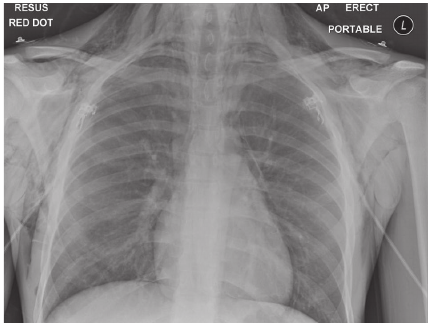
Figure 1: Chest X-ray.